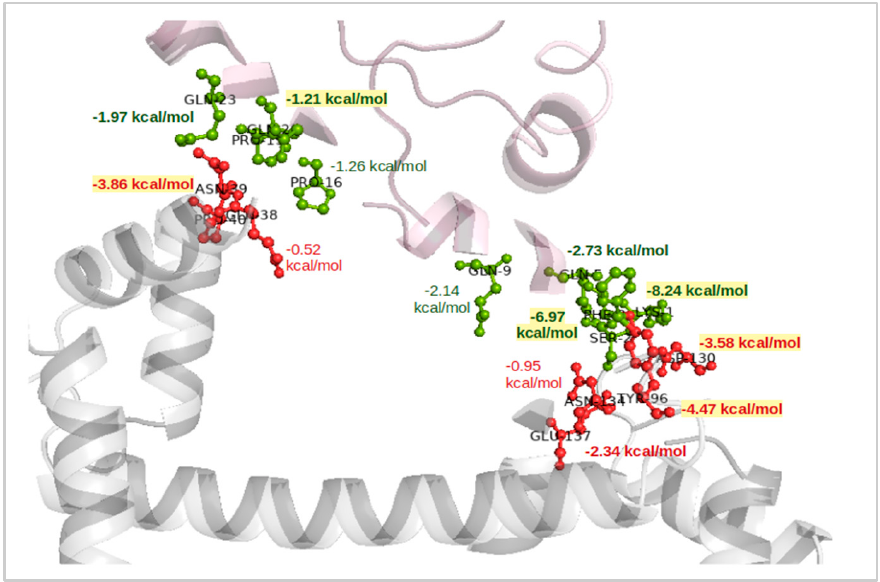
Figure 5. Per ‐ residue contributions for CaM–9P(EM) docked complex and their corresponding Figure 5. Per-residue contributions for CaM–9P(EM) docked complex and their corresponding binding free energies. binding free